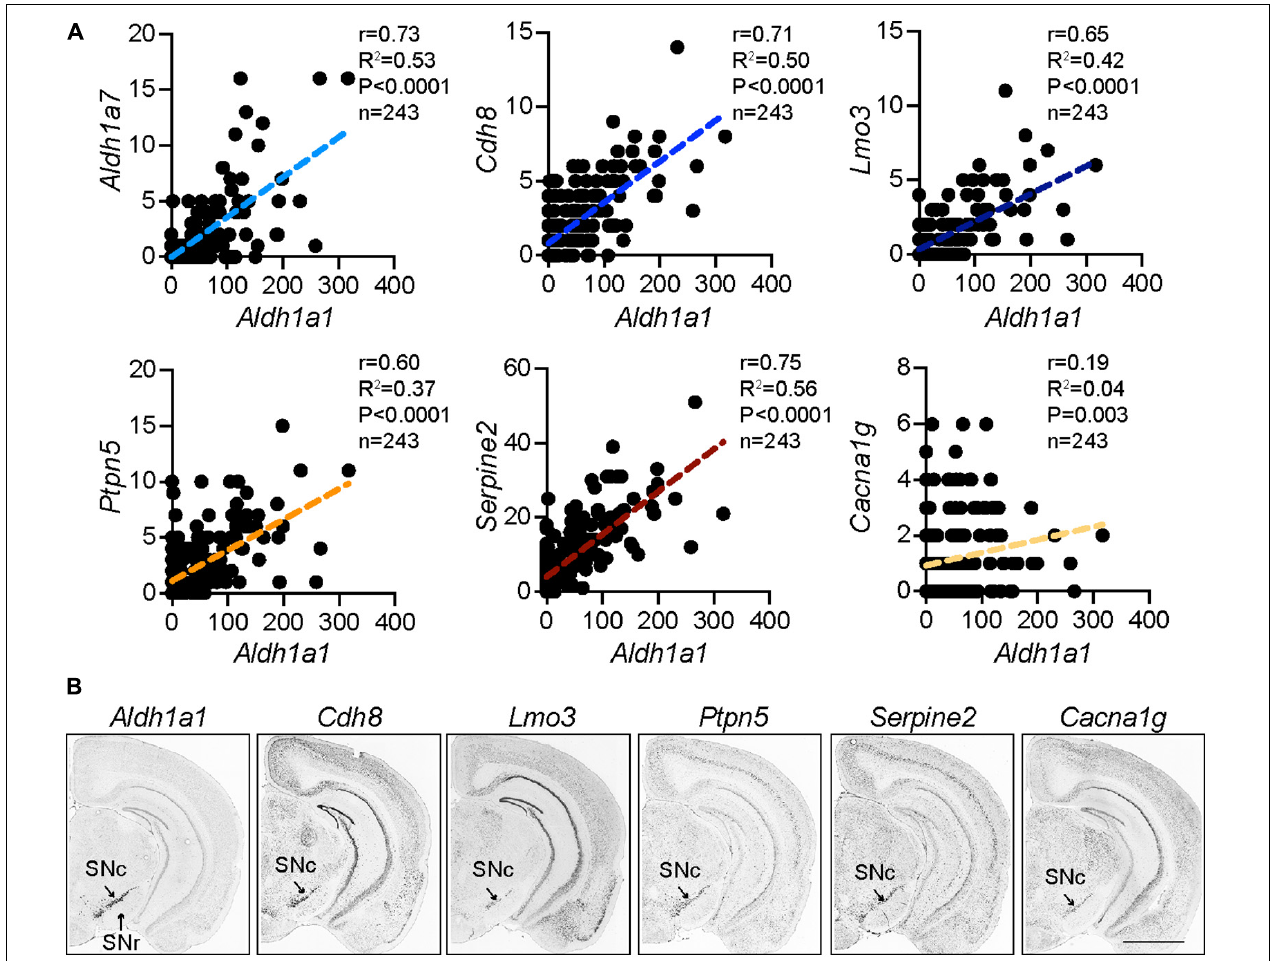
FIGURE 1 | Distinct molecular signature of ALDH1A1 + nDANs. (A) Correlation of Aldh1a1 expression with a selective set of genes in mature mouse DANs from a single cell RNA sequencing study (La Manno et al., 2016). (B) In situ hybridization of Aldh1a1 and correlated genes in the SNc of adult mouse brains (Allen Brain